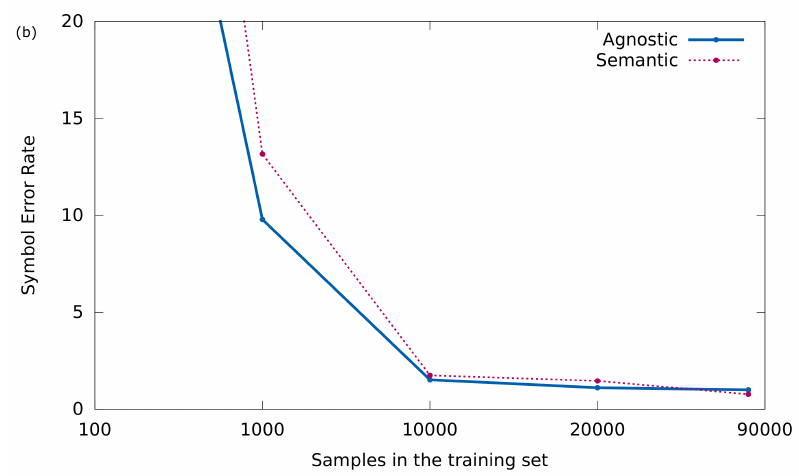
Figure 6. Comparison between agnostic and semantic representations in the evolution of the evaluation metrics with respect to the size of the training set. Note that the x -axis does not present a linear scale. ( a ) Sequence Error Rate; ( b ) Symbol Error Rate.